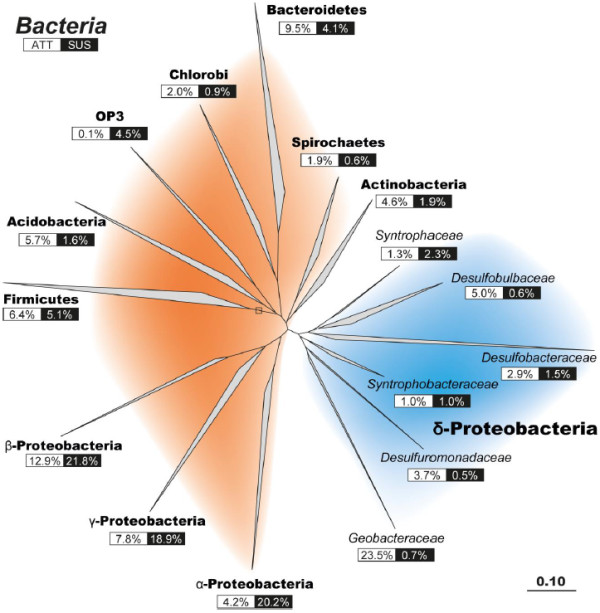
Phylogenetic tree of bacterial 16S rRNA genes generated using sequences from the Greengenes database [34] and cloned sequences from this study. The relative proportion of clones in the attached (ATT) or suspended (SUS) libraries is indicated below the label of each branch. Colored backgrounds distinguish the clades within the ∂-Proteobacteria (blue) from the other bacterial phyla (orange).